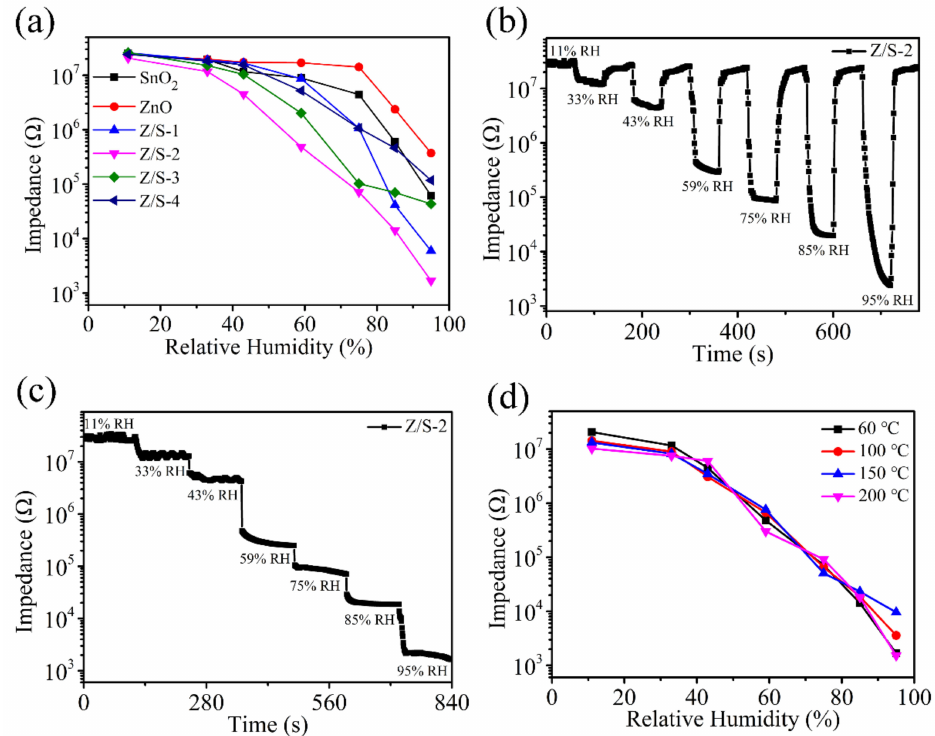
Figure 9. ( a ) Impedance changes of humidity sensors at 100 Hz, ( b ) response and recovery character- istics of Z/S-2 humidity sensor at different RHs, ( c ) impedance curve of Z/S-2 humidity sensor at different RHs, and ( d ) impedance response curves of Z/S-2 humidity sensor at drying temperatures of 60, 100, 150, and 200 ◦ C.